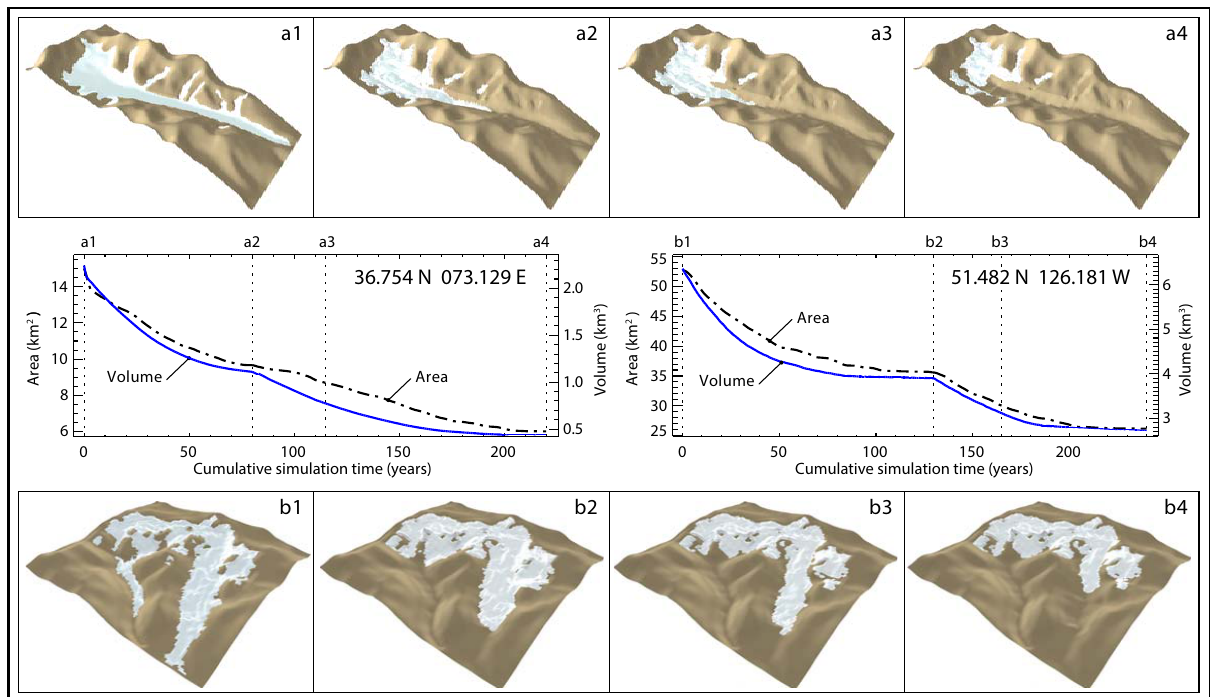
Fig. 2. Evolution of area (dash-dotted) and volume (blue) as calculated with the ice-dynamics model for two selected glaciers. “a1” and “b1” correspond to the initial glacier geometries as given by Huss and Farinotti (2012). “a2” and “b2” are the steady states reached after imposing an ELA yielding AAR=0.44 for the initial geometry. “a4” and “b4” are the steady-state configurations after the ELA has been increased by 100m, and “a3” and “b3” are a transient configuration about mid-way between the two steady states. The pronounced volume loss occurring between states “1” and “2” is the consequence of forcing present-day glacier geometries with present-day AARs, and reflects the imbalance between current glacier geometries and